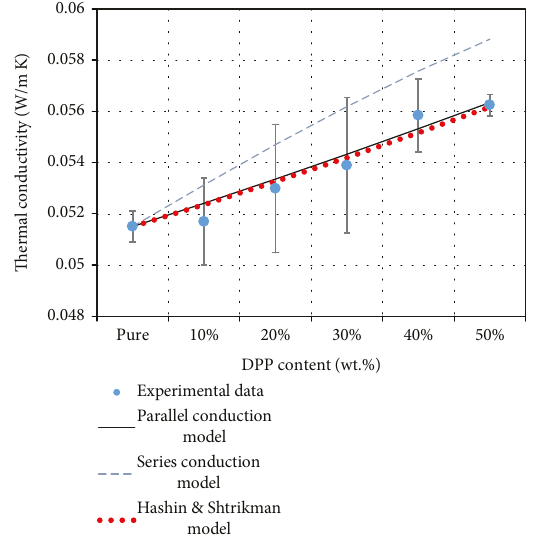
Figure 8: Thermal conductivity of composites for di ff erent DPP contents at room temperature (25 °